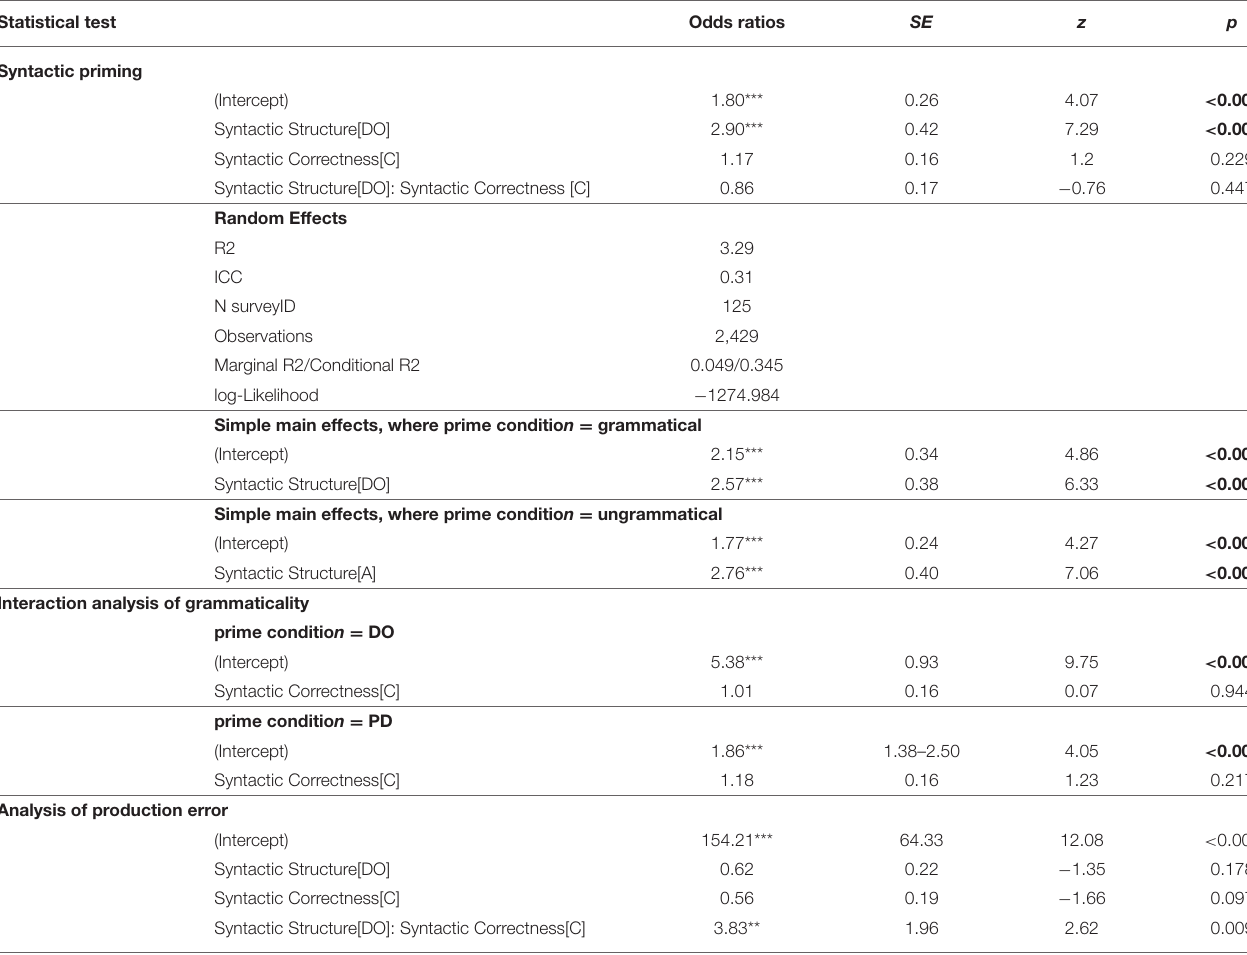
TABLE 3.2 | Logistic fixed effects model coefficients and statistical tests from experiment 2. Statistical